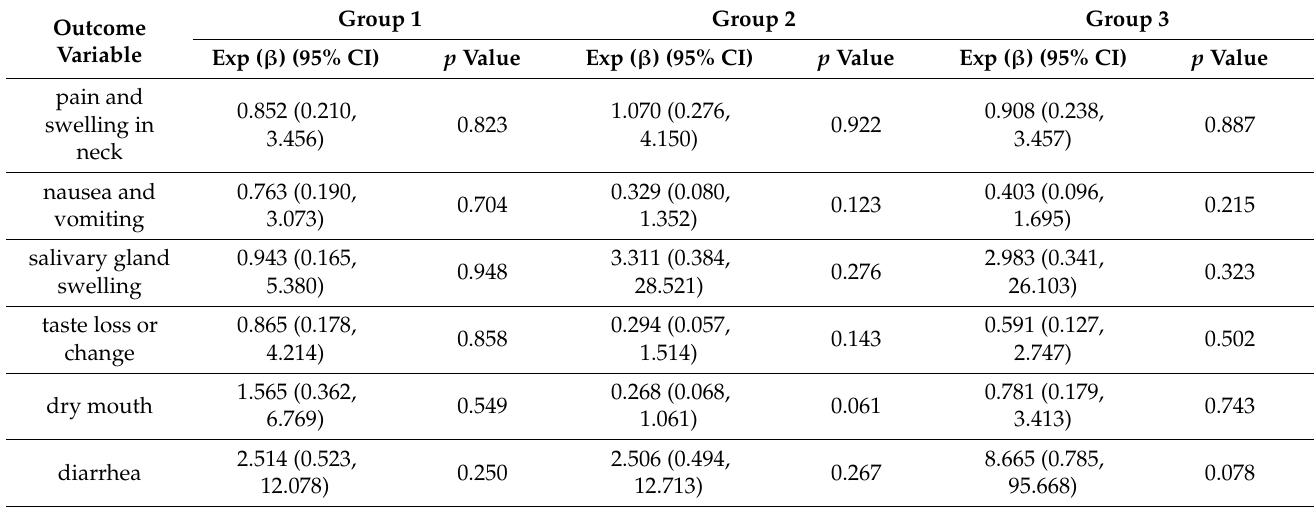
Table 4. The odds ratio and p values of different clinical outcomes for the GEE model. Each intervention group was compared with the placebo.